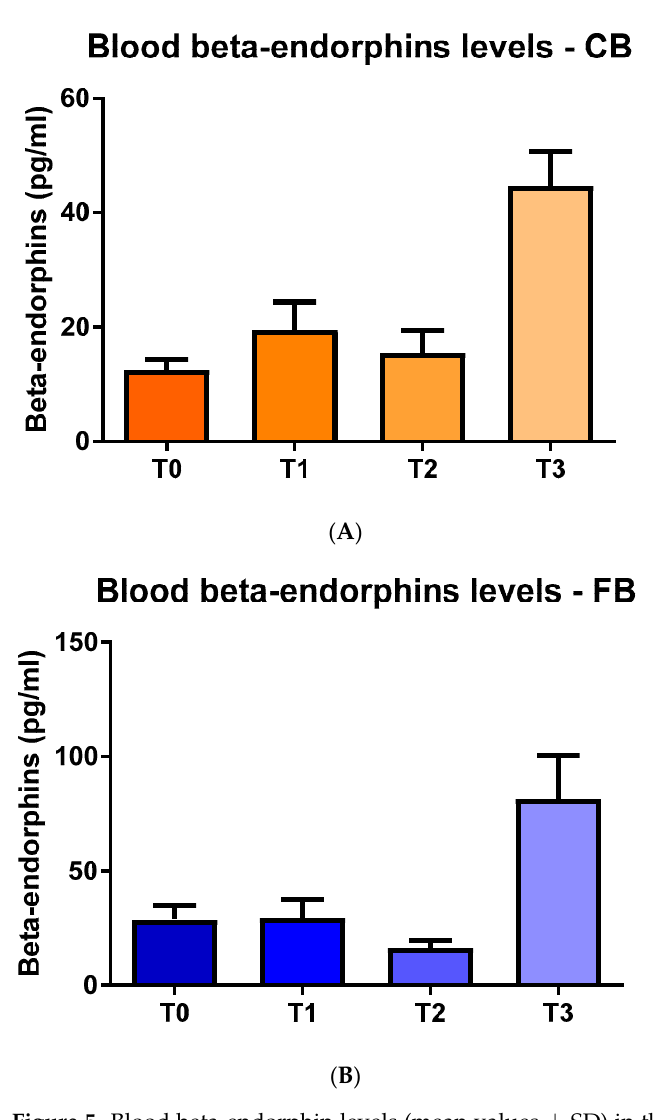
Figure 5 . Blood beta ‐ endorphin levels (mean values ± SD) in the ( A ) compost barn (CB) and the ( B ) Figure 5. Blood beta-endorphin levels (mean values ± SD) in the ( A ) compost barn (CB) and the freestall barn (FB) groups. ( B ) freestall barn (FB)